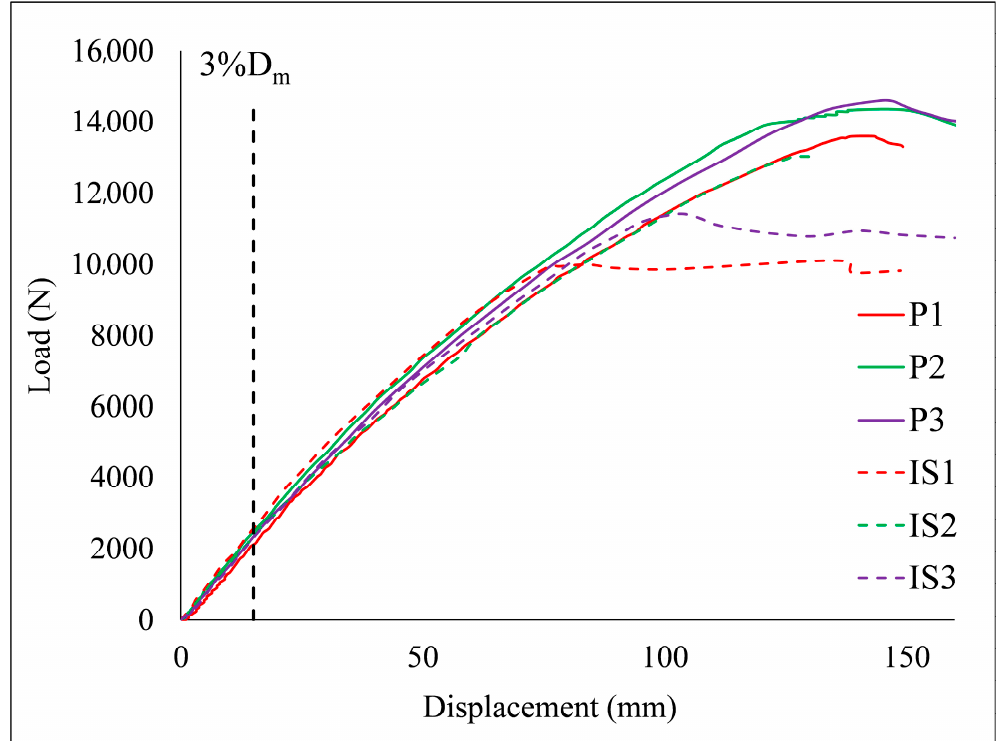
Figure 9. Load-displacement response of DN500 pipes obtained by the plain type (P1, P2, and P3) and the outer stiffened type (OS1, OS2, and OS3), respectively.